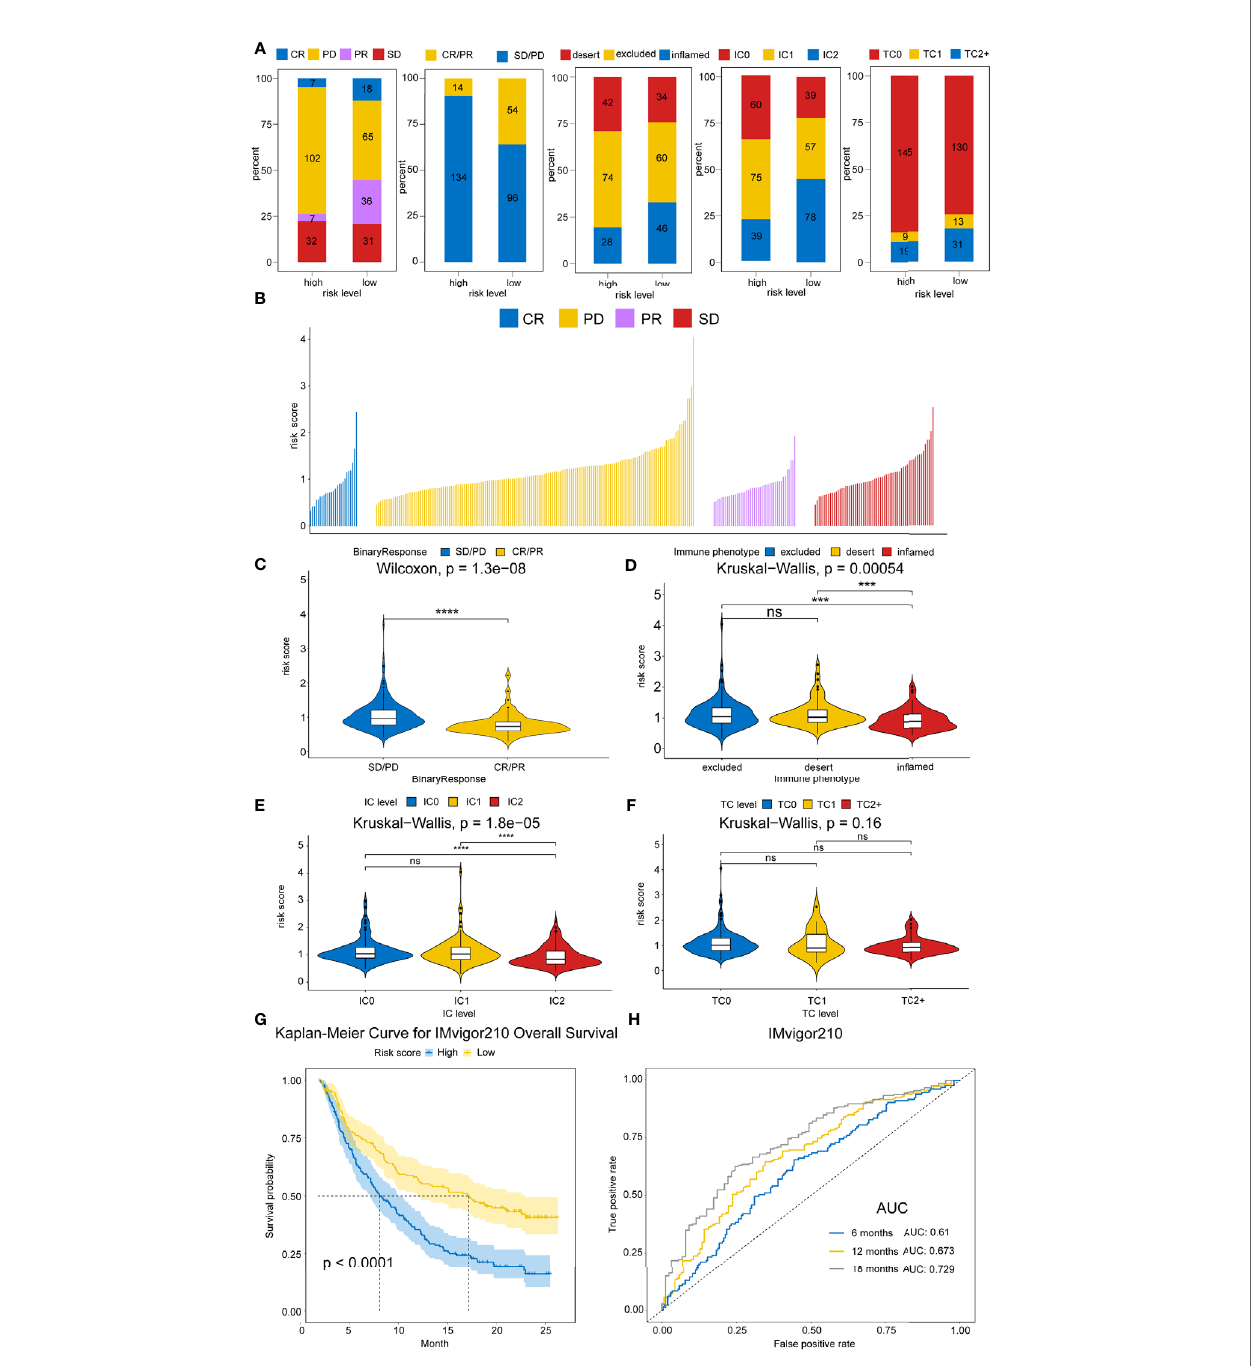
FIGURE 9 | Therapeutic bene fi ts of risk scores calculated by our model. (A) Bar graphs illustrate the distribution of the clinicopathological parameters for IMvigor210 dataset in high- and low-risk patients based on chi-square test. (P=4.8008E-08, P=4.8008E-08, P=0.3305, P=6.0E-6, and P=1.6023E-59, respectively). (B) Waterfall plot illustrates the risk score distributions for patients exhibiting different immunotherapeutic responses in the IMvigor210 dataset. (C) Violin plot illustrates the risk score distributions for patients exhibiting different anti-PD-L1 immunotherapies in IMvigor210 dataset. (D) Violin plot illustrates the risk score distributions for patients exhibiting different immune phenotypes in the IMvigor210 dataset. (E) Violin plot illustrates the risk score distributions for patients with varying IC levels in the IMvigor210 dataset. (F) Violin plot illustrates the risk score distributions for patients with varying TC levels in the IMvigor210 dataset. (G) Kaplan – Meier curves for OS outcomes in the IMvigor210 cohort assigned into high- and low-risk score groups. (H) Time-dependence ROC curves of anti-PD-L1 immunotherapy response prediction at 0.5-, 1-, and 1.5-year survival rate in the IMvigor210 dataset. Signi fi cance: ns ≥ 0.05, ∗∗∗ <0.001, and ∗∗∗∗